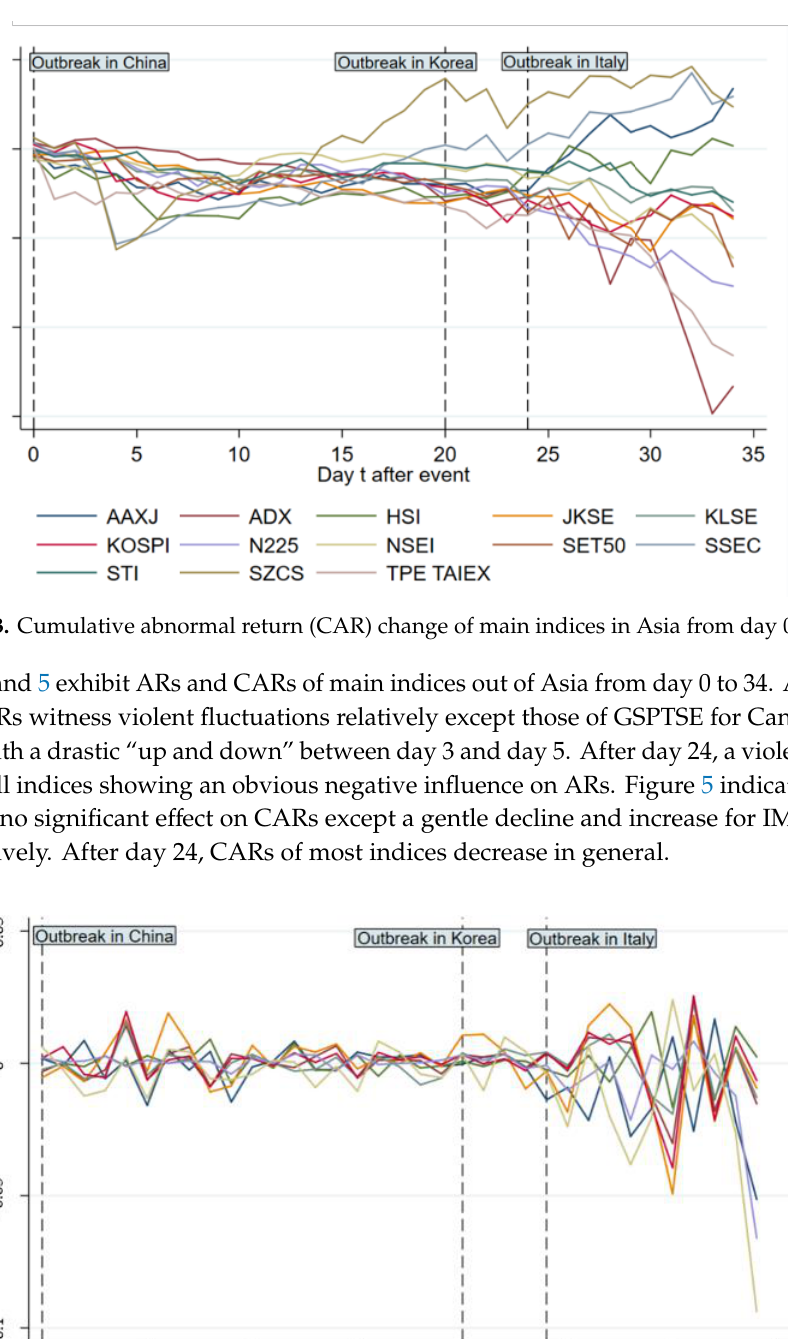
Figure 2. Abnormal Return (AR) change of main indices in Asia from day 0 to 34.